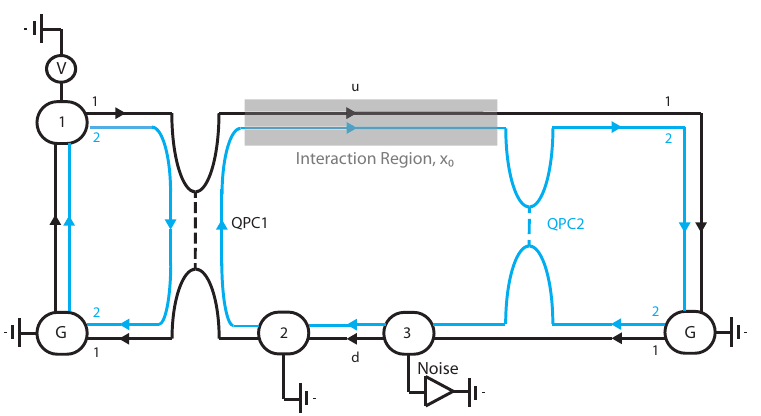
Figure 7: Sketch of a ν = 2 Hall bar with a QPC1, where inner modes (2, light blue lines) are fully reflected, while partial transmission of outer modes (1, black lines) is possible. At a QPC2, the opposite situation is realized. The shaded area is the interaction region. The upper edge is biased with voltage V at contact 1; current noise is measured at contact